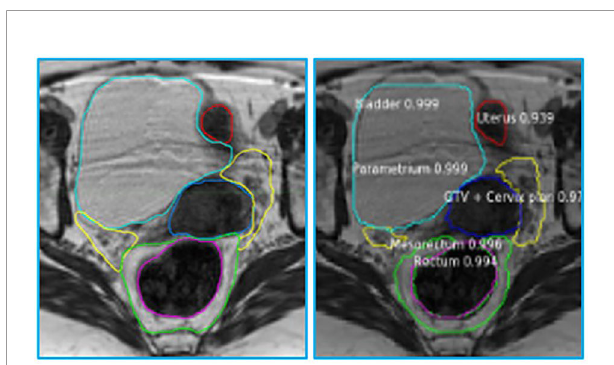
FIGURE 3 | Manual (left) and automatic (right) contours on the original MRI image from a patient with cervical cancer. The contours generated by MASK R-CNN contain a con fi dence estimate, a number between 0 and 1, with 0 representing mimmum and 1 maximum con fi dence that the class, assigned to the segmented volume is accurate. Please refer to Figure 1 legend for color scheme.